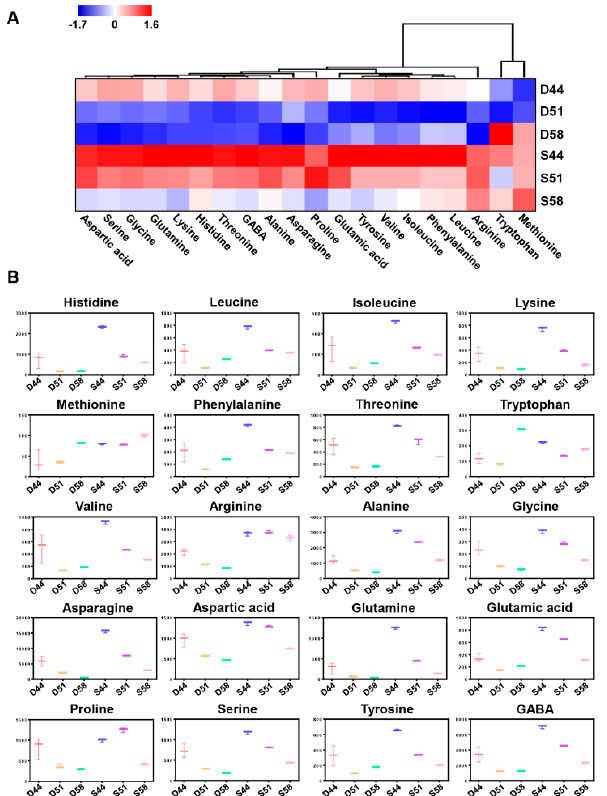
Figure 4. Relative quantification of free amino acids in filling stage seeds. ( A ) HCA clustering of each amino acid by MeV software, where red and blue colors indicate up- and down-regulation, respectively. ( B ) Box plots of 20 amino acids represent differential contents of nine essential and eleven nonessential amino acids. Error bars indicate standard deviations obtained by three replicates of the same sample.